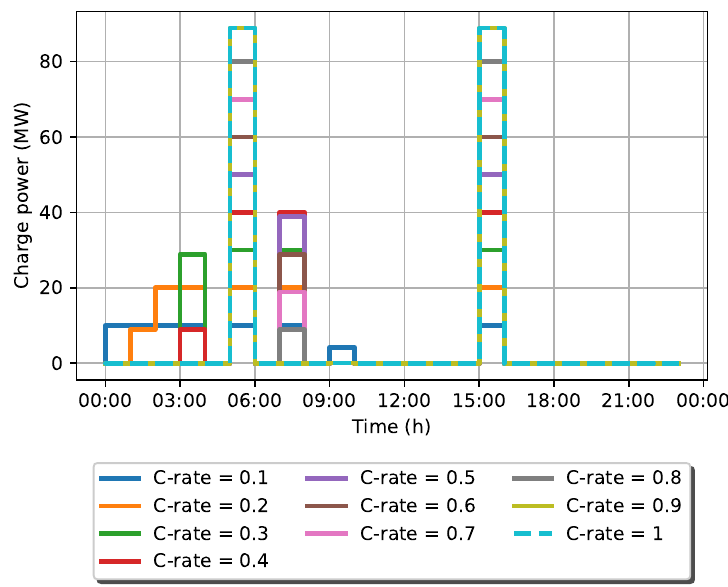
Figure 10. Energy storage charge operation for 10 May 2020, Study case A.